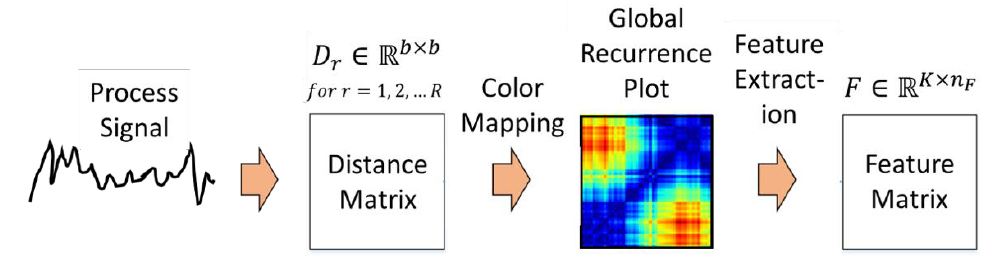
Figure 6. CNN feature extraction from global recurrence plots.